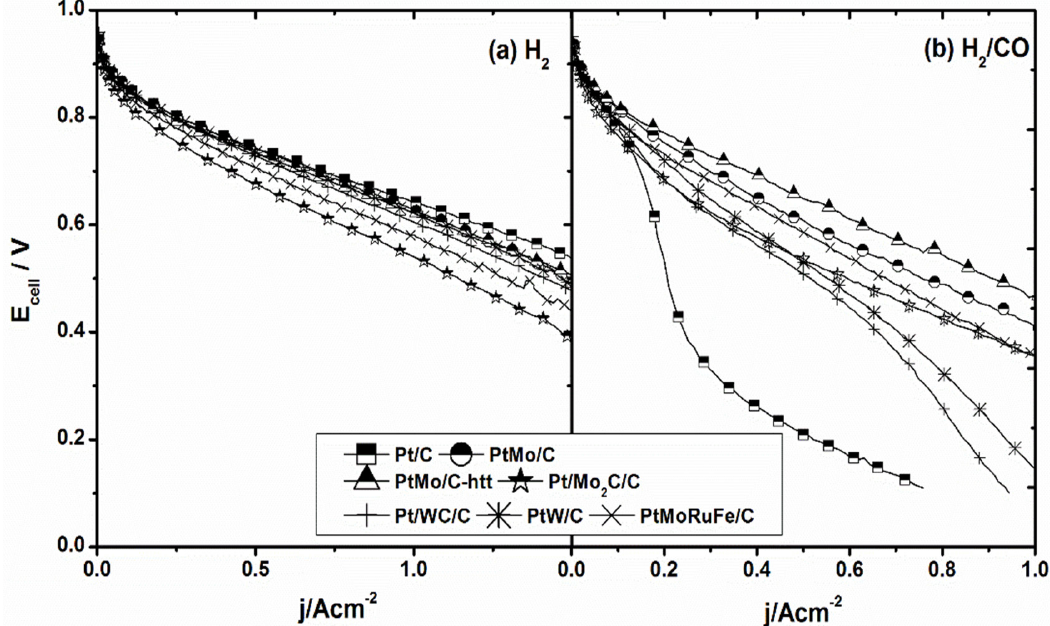
Figure 4 - Single fuel cell voltage-current density curves obtained at cell temperature of 85 ° C. The anodes Pt, PtMo, PtMo-heat treated (600 o C) supported on carbon, Pt supported on carbides, and carbon supported PtW and PtMoRuFe catalysts were supplied with ( a ) pure H and ( b ) H /CO mixture and the carbon supported Pt cathodes were feed with 2 2 O 2